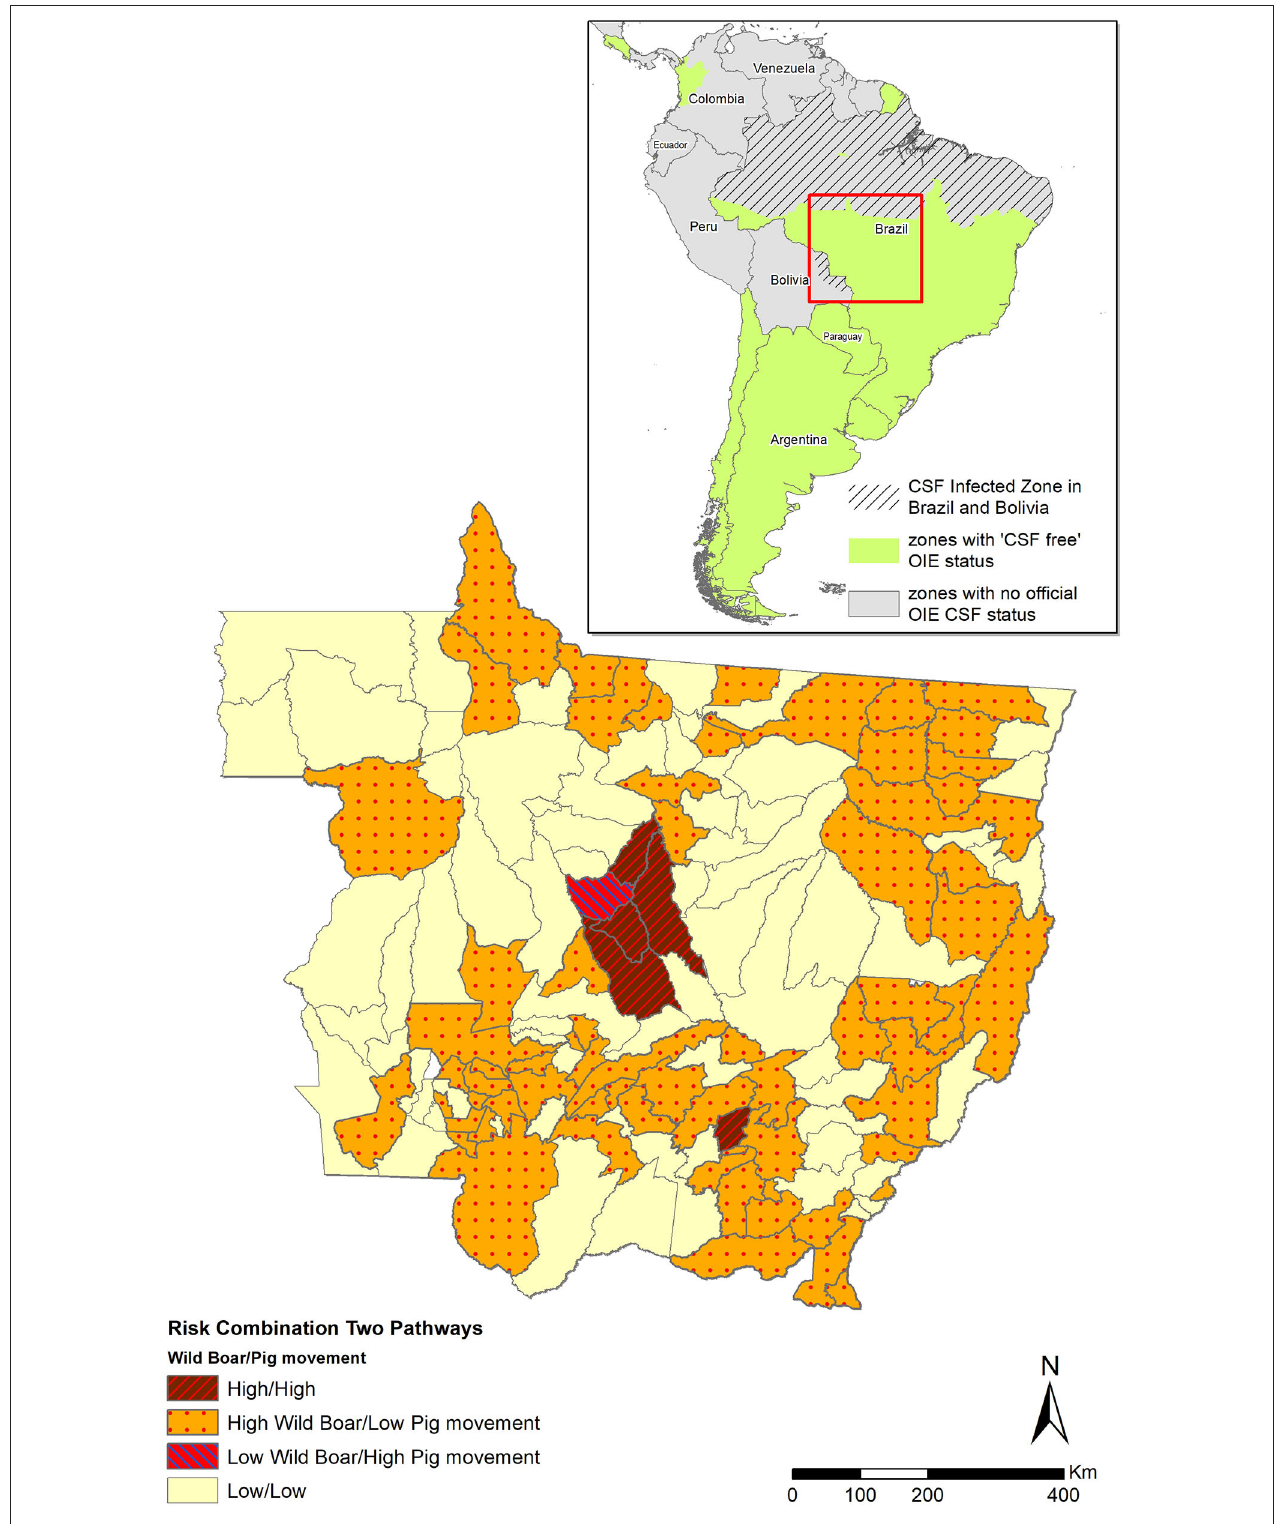
FIGURE 4 | Risk for the introduction of CSF into MT through legal movement of pigs and through free roaming of wild boars, estimated using a combination of risk analysis models. Municipalities were categorized as high risk for both pathways (brown with red hatched area), high risk for wild boars and low risk for commercial pig movements (orange with red dots), low risk for wild boars and high risk for commercial pig movements (pink with blue hatched area), and low risk for both pathways (light yellow). The green area in the Latin America map (up right corner) shows the CSF-free area recognized by OIE. The hatched gray area shows the non-CSF-free